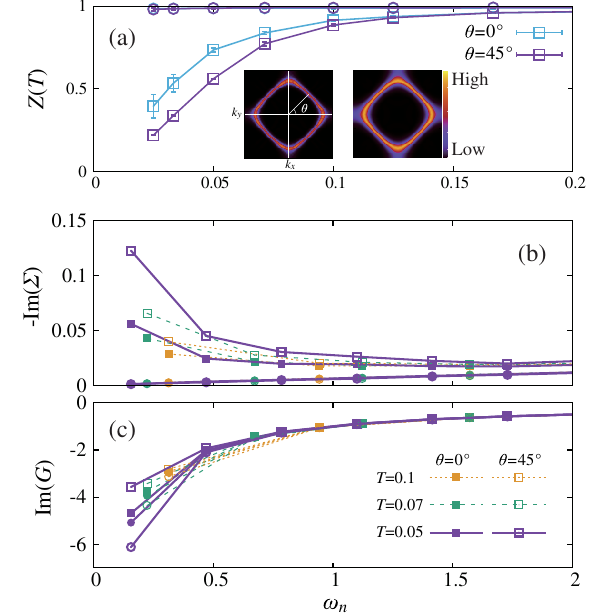
FIG. 2. (a) Z k ð T Þ at FM QCP ( h c ¼ 3 . 27 , squares) and in the F PM phase ( h ¼ 3 . 60 , circles). The left inset is the G ½ k ; ð β = 2 Þ(cid:3) at the FS for T ¼ 0 . 05 , while the right inset is for T ¼ 0 . 1 . Although there is anisotropy in Z k at different parts of the FS, the F quasiparticle weight in the k x and k x ¼ k y directions both approach zero at FM QCP, indicating a non-Fermi liquid behavior for the entire FS. The data in the PM phase show the quasiparticle weight approaching a constant (very close to 1), indicating the system is a Fermi liquid. Panel (b) shows − Im ( Σ ð k F ; ω n Þ ) at FM QCP ( h ¼ h c , square symbol). It increases as ω n → 0 (signifying the system at QCP loses its quasiparticle weight with a power law), a non-Fermi liquid behavior, while in the PM phase ( h ¼ 3 . 60 , circle symbol), the imaginary part of the self-energy approaches zero linearly as ω n → 0 — a Fermi-liquid behavior. (c) Imaginary part of the single-fermion Green ’ s function at the FM QCP ( h ¼ 3 . 27 , square symbol) and in the PM phase ( h ¼ 3 . 60 , circle symbol). No signature of the gap formation is ( θ ¼ ð π = 4 Þ ) in comparison with other parts of the FS (e.g.,